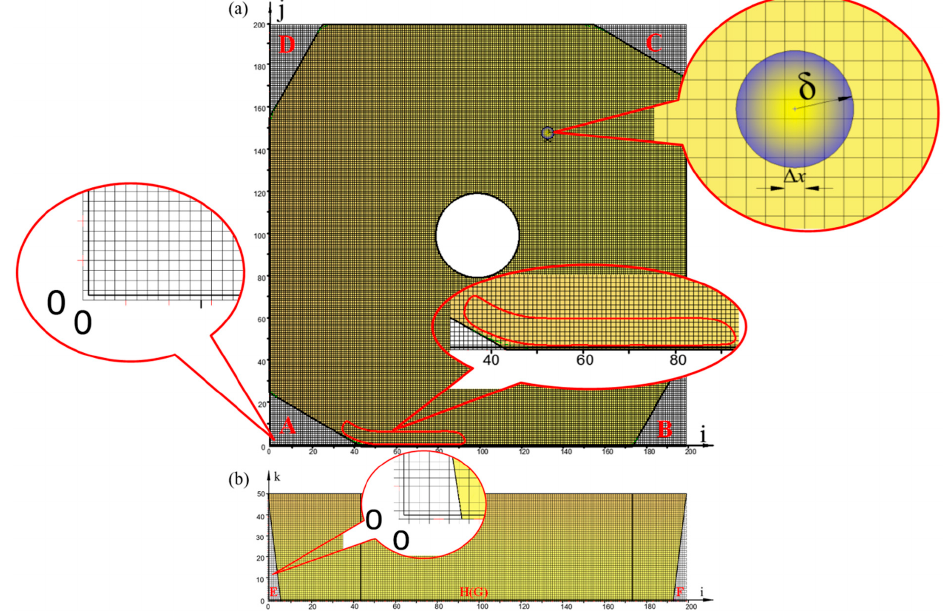
limit and so on. In the process of PD analysis, it is necessary to determine the main mo-